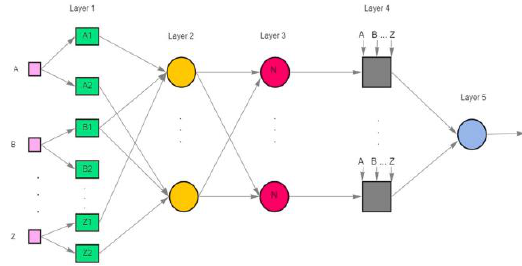
Figure 9. ANFIS model.